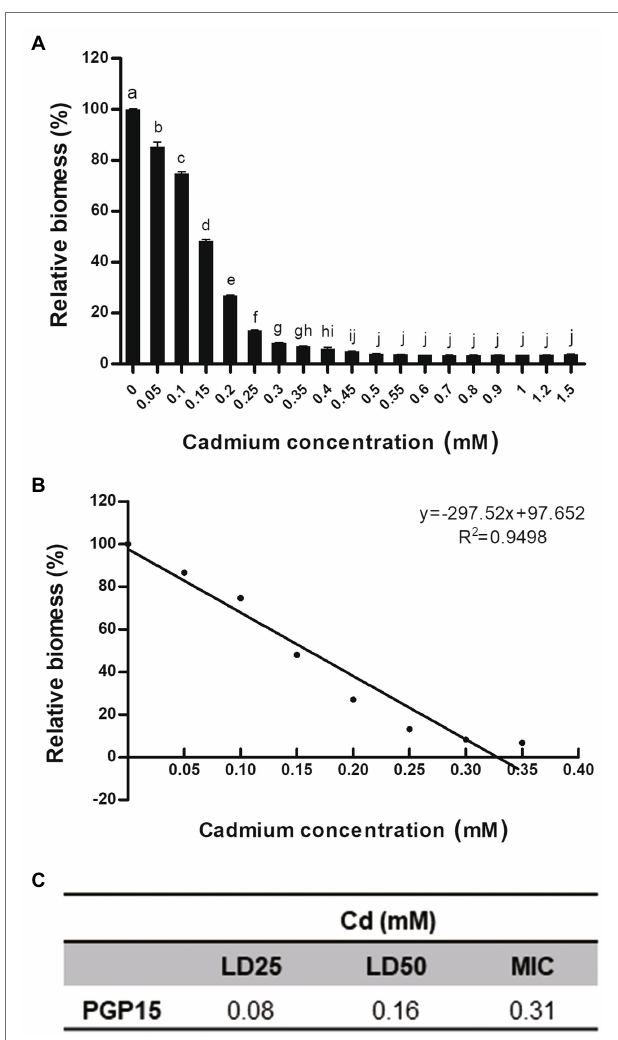
FIGURE 2 | The Cd resistance profile for strain PGP15. (A) Relative biomass of strain PGP15 during cadmium treatments. (B) Linear relationship between the relative biomass of strain PGP15 and the cadmium concentrations in the medium. The growth of strain PGP15 was studied under a gradient of cadmium concentrations. The relative biomass was calculated by comparing the biomass (OD600) of different treatments with that of the control. Error bars are standard errors of the means of three replicates. (C) The LD25, LD50, and MIC of strain PGP15 when exposed to Cd. LD, lethal dose; MIC, minimum inhibitory